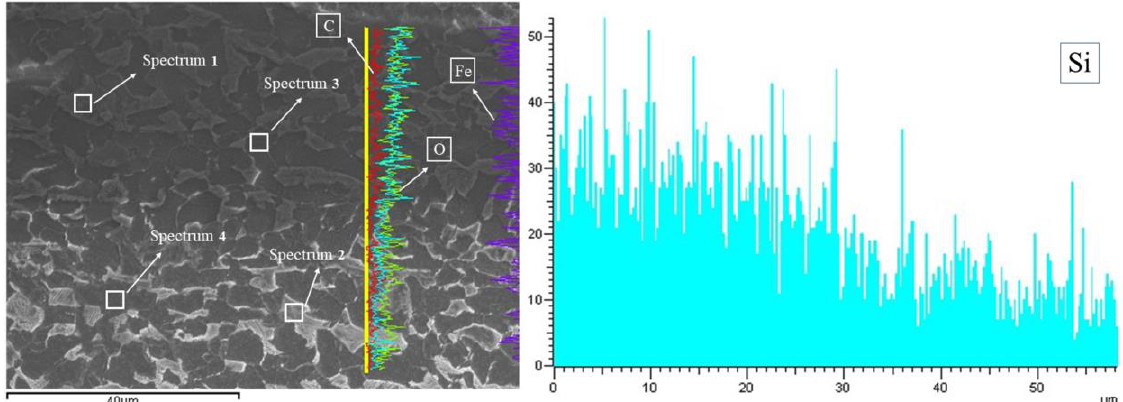
Figure 5. The cross-sectional SEM image and EDS analysis of the sample after 3 mm-2080 W-11 mm-400 s USP treatment.